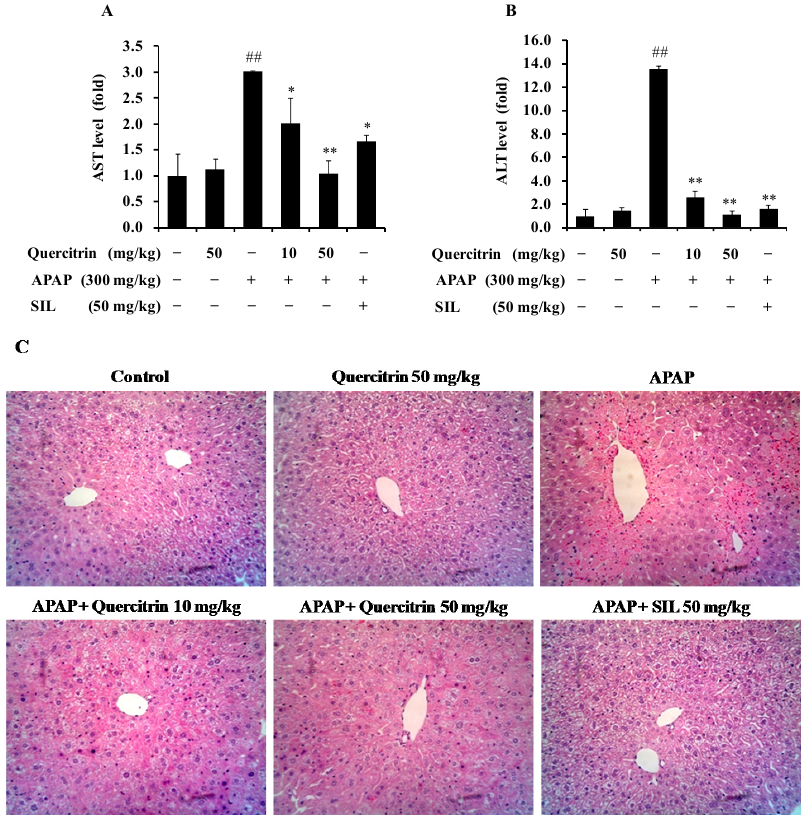
Figure 4. Protective effects of quercitrin on APAP intoxicated mice. Mice were orally administered quercitrin of 10 or 50 mg/kg once a day for seven days. The control group received the same volume of saline. After the seventh gavage of quercitrin or saline, animals received a single injection of APAP (300 mg/kg). All mice were sacrificed at 24 h after APAP injection to obtain blood and liver. Serum ALT ( A ) and AST ( B ) levels; and H&E staining ( C ). All data represent means ± SD of five mice in each group. Significant differences were ( ## ) p < 0.01 as compared with the control; (**) p < 0.01 or (*) p < 0.05 as compared with APAP